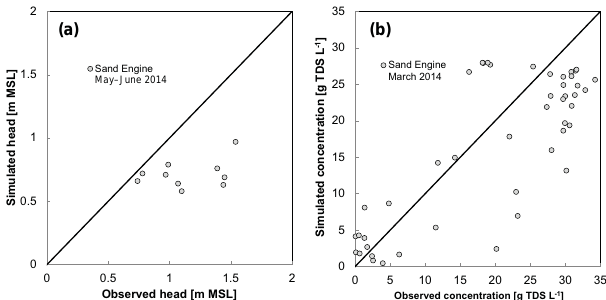
Figure 9. Comparison of (a) average groundwater heads in May– June 2014 and (b) (single) TDS concentrations of soil samples taken between 10 and 14 March 2014 with model simulations in the Sand